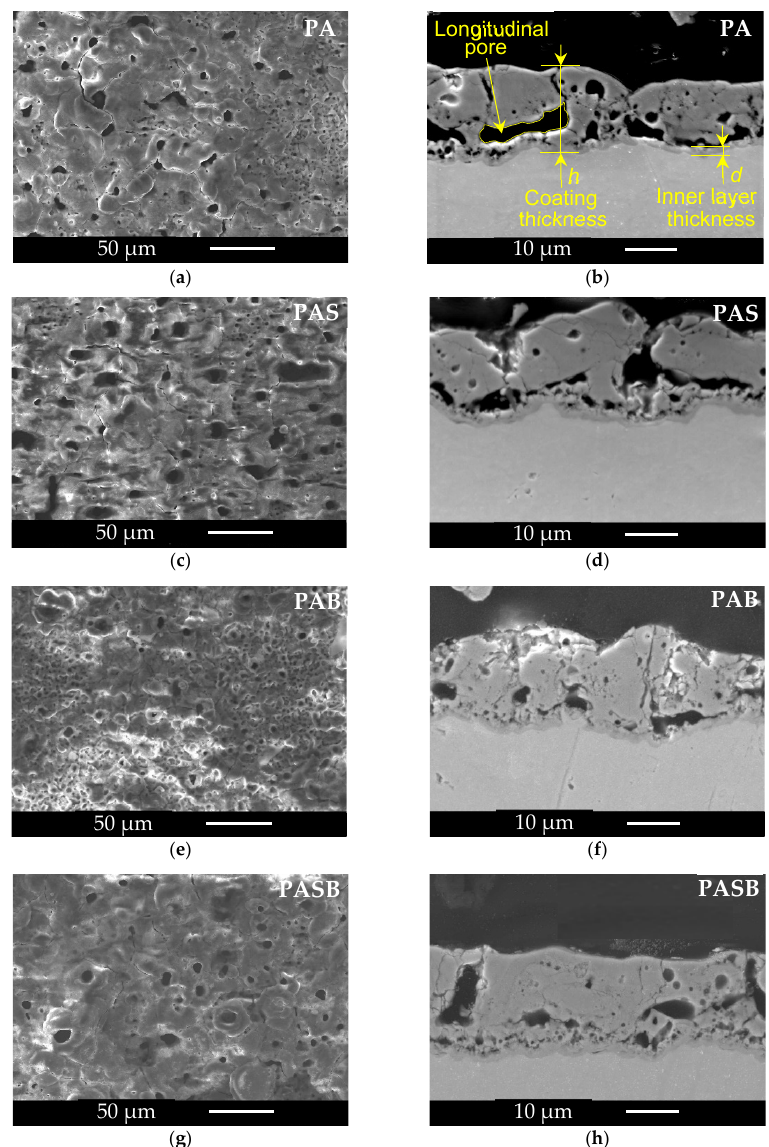
Figure 2. Surface morphologies of the PEO coatings produced in ( a ) PA, ( c ) PAS, ( e ) PAB, ( g ) PASB electrolytes, and cross sections of the coatings ( b ) PA, ( d ) PAS, ( f ) PAB, ( h )